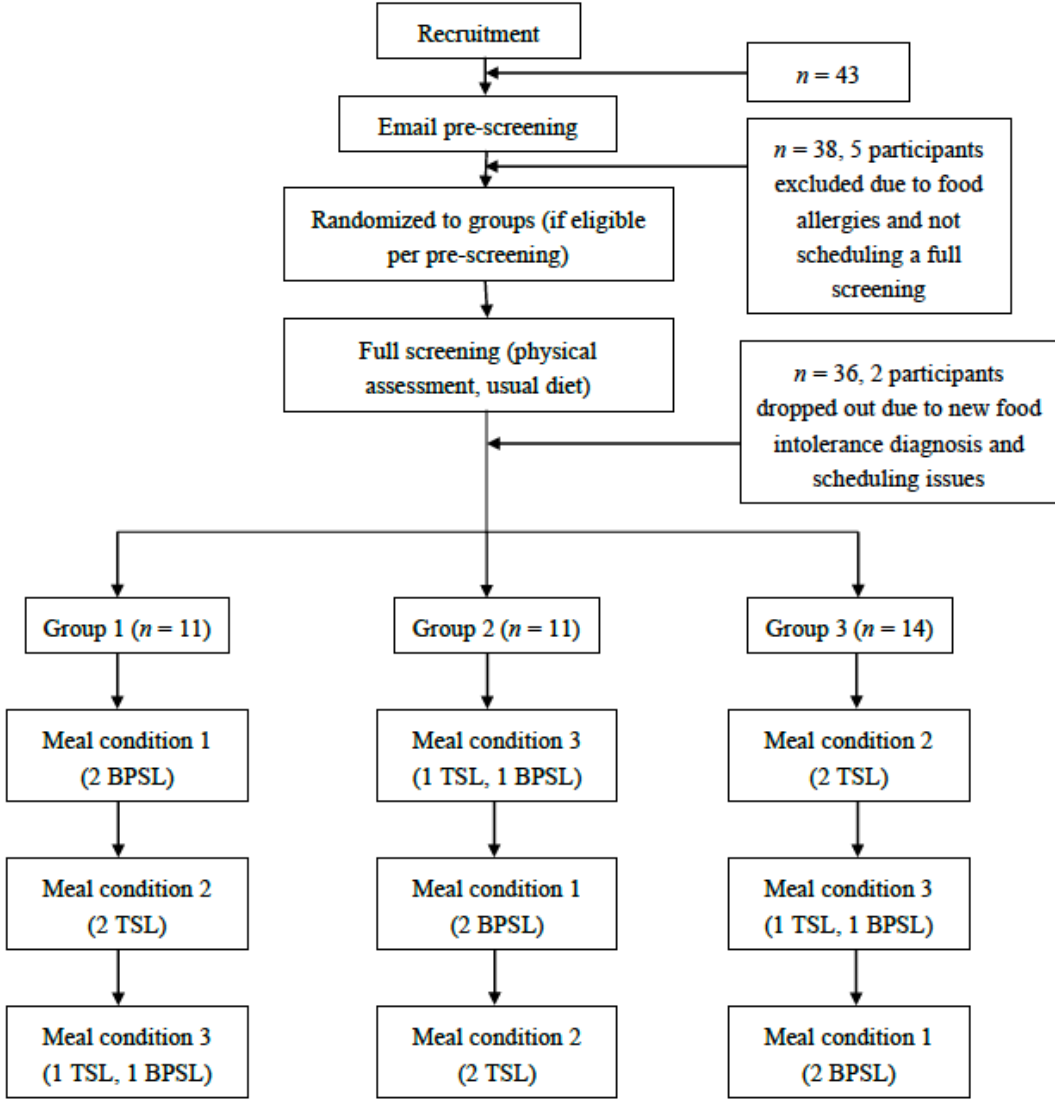
Figure 1. Flow chart of randomized crossover study design (typical school lunch, TSL; best practice school lunch, BPSL).